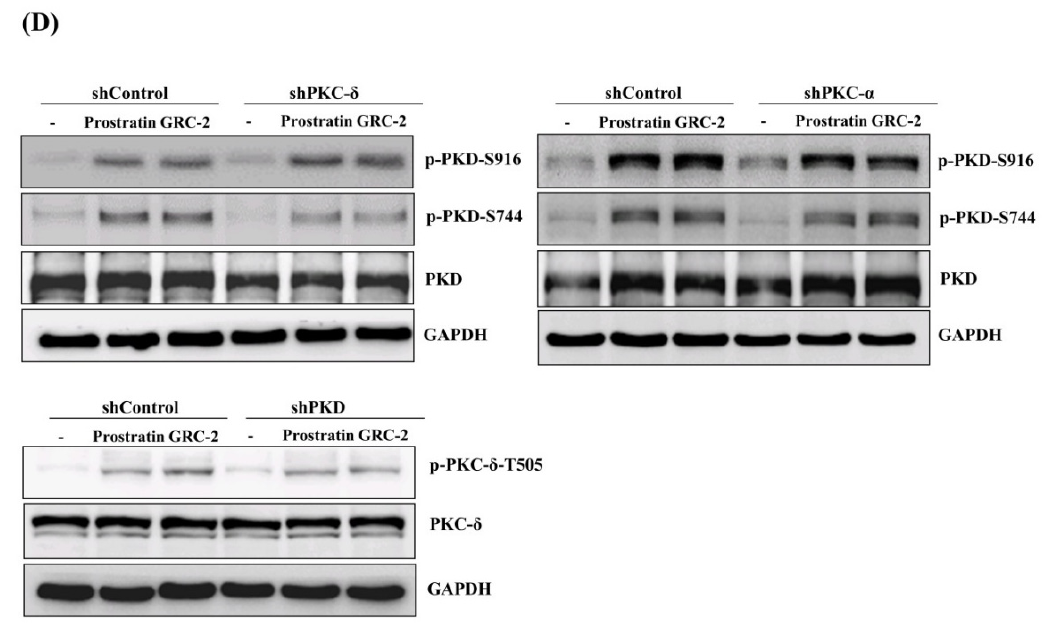
Figure 4. Knockdown of PKC- δ /PKD attenuates the cytotoxicity of prostratin and GRC-2 in A549 cells. A549 cells were transfected with lentiviral vectors encoding shRNA of interest or a control vector. Transfected cells were treated with DMSO, prostratin (3 μ M) or GRC-2 (300 nM) for 72 h ( A – C ) or 15 min ( D ), then ( A ) cell viability, ( B ) cell cycle, ( C ) apoptosis, and ( D ) protein expression were measured by MTT assay, PI staining, annexin V/PI staining, and immunoblotting, respectively. The data from ( C ) are presented as fold increases in late apoptosis compared to the control vector. Results are presented as mean ± S.E.M. ( n = 3). * p < 0.05, ** p < 0.01 and *** p < 0.001 as compared with the respective control.